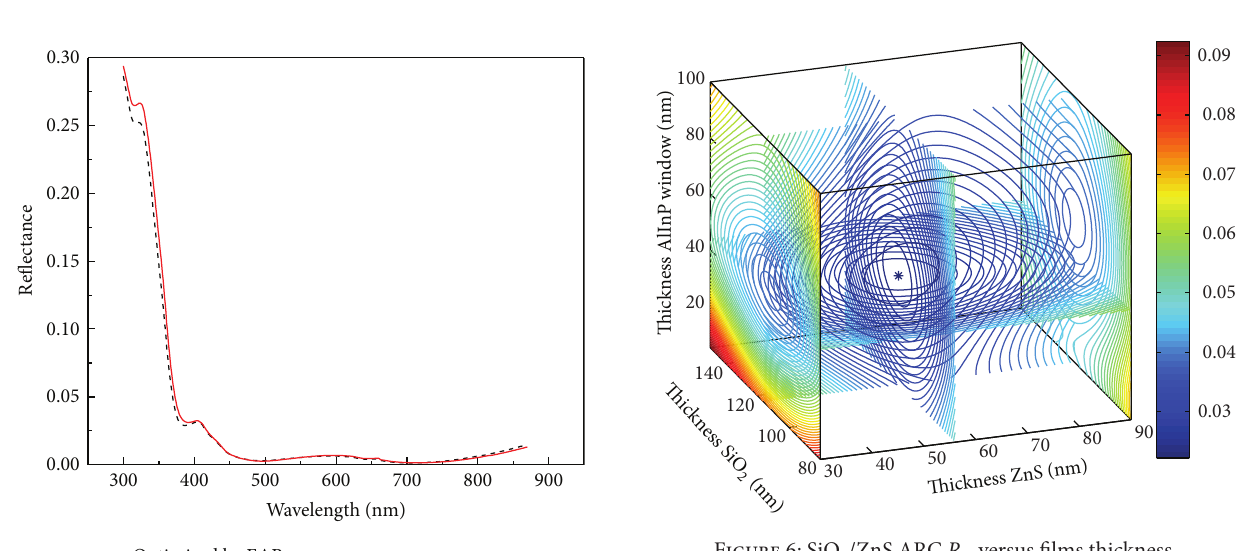
Figure 6: SiO 2 /ZnS ARC 𝑅 𝑤 versus films thickness. Those optimized by WAR and EAR methods also exhib- ited minimal differences in triple junction SC (see in Table 2), with the change in thickness values being less than 2 nm and the reflectivities in the spectral range of 400–700 nm remaining almost unchanged. The reflectivities are properly the lowest where the solar photon flux is mainly distributed (see Figure 7). These results indicated that optimizing the ARC by minimizing the effective average reflectance 𝑅 𝑒 for double-junction SC is